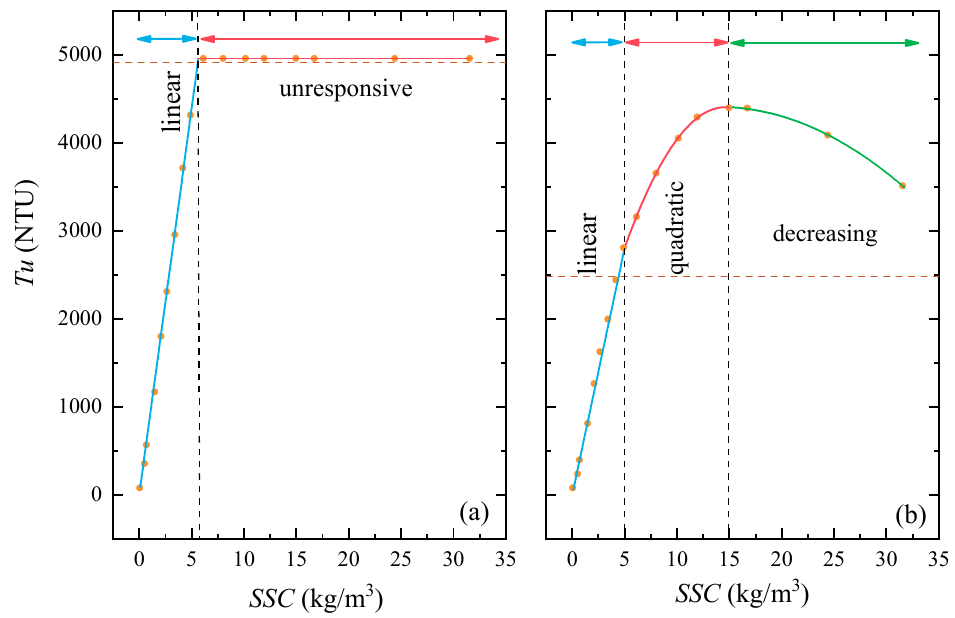
Figure 3. Laboratory calibration for OBS-3A on the tripod showing the response of Tu to SSC of the lab samples: ( a ) 0.4 m asb; ( b ) 1.0 m asb. The dashed horizontal lines mark the maximum values of the measured turbidity.